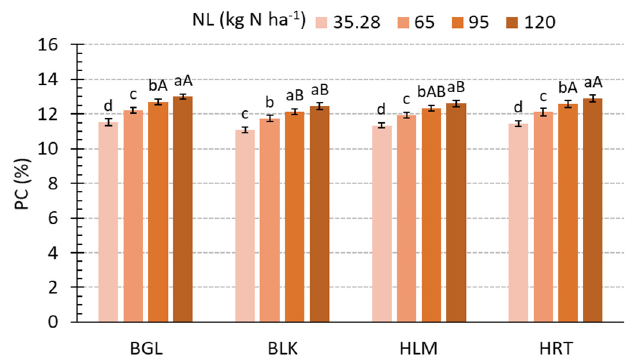
Figure 4. The effect of nitrogen fertilization level (NL) at the four locations (BGL: Baghlan; BLK: Balkh; HLM: Helmand; HRT: Herat) on the protein concentration in grain (PC). Lowercase letters represent significant differences between PL levels within the same locations, and uppercase letters represent significant differences between locations within the same PL level according to the Tukey HSD post hoc test results.